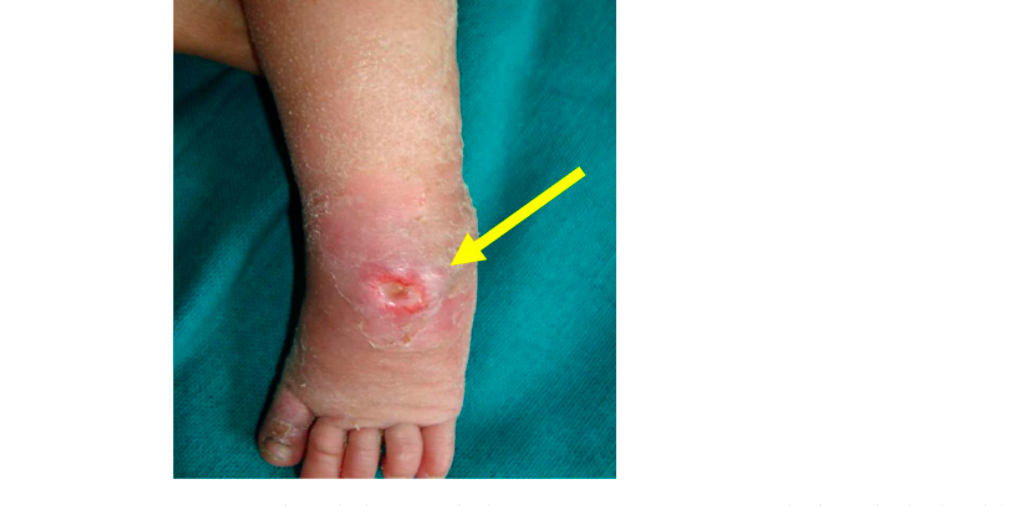
Figure 7. Clinical photograph showing a pressure area over the lateral talar head (pointed by the arrow) due to excessive pressure in one area during the casting process.